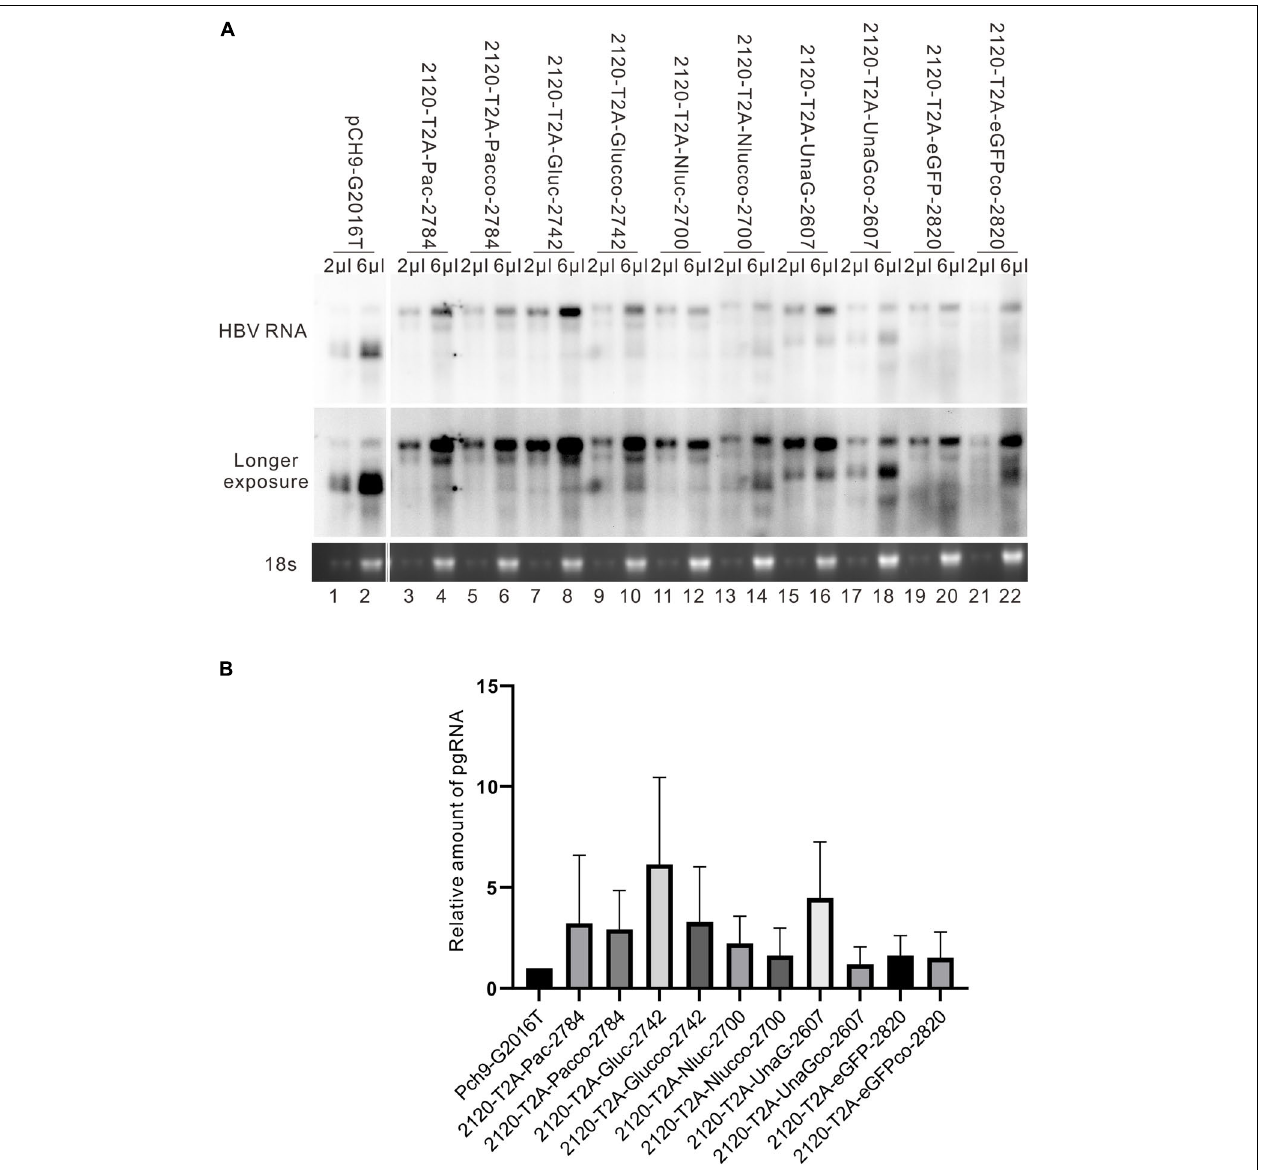
FIGURE 10 | HBV RNA assay of the recombinants before and after sequence optimization. (A) Representative Northern blotting of the recombinants before and after sequence optimization. (B) The relative intensity of pgRNA of the recombinants before and after sequence optimization. The ratio of each pgRNA/18s rRNA was calculated, and this ratio was then divided into the sum of pgRNA/18s rRNA of all samples in the same membrane to calculate the relative intensity of pgRNA of each sample. N = 3.